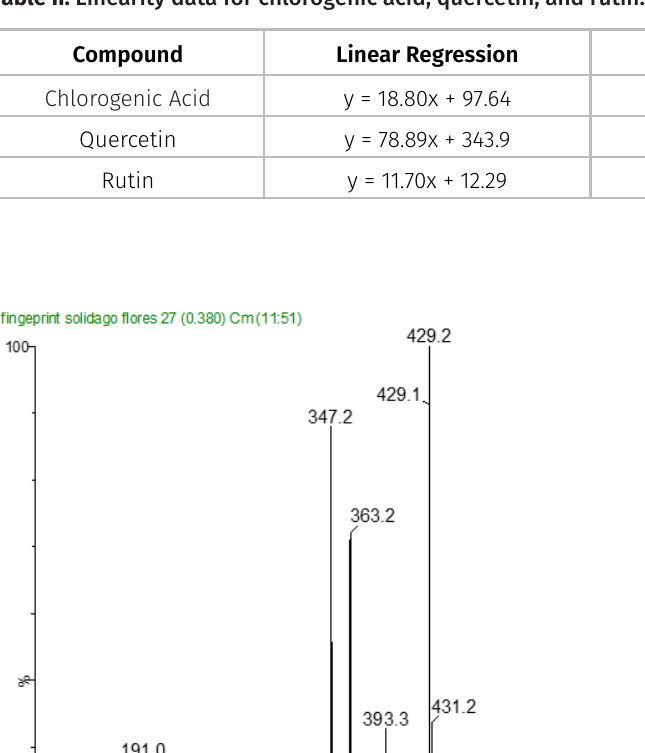
Table II. Linearity data for chlorogenic acid, quercetin, and